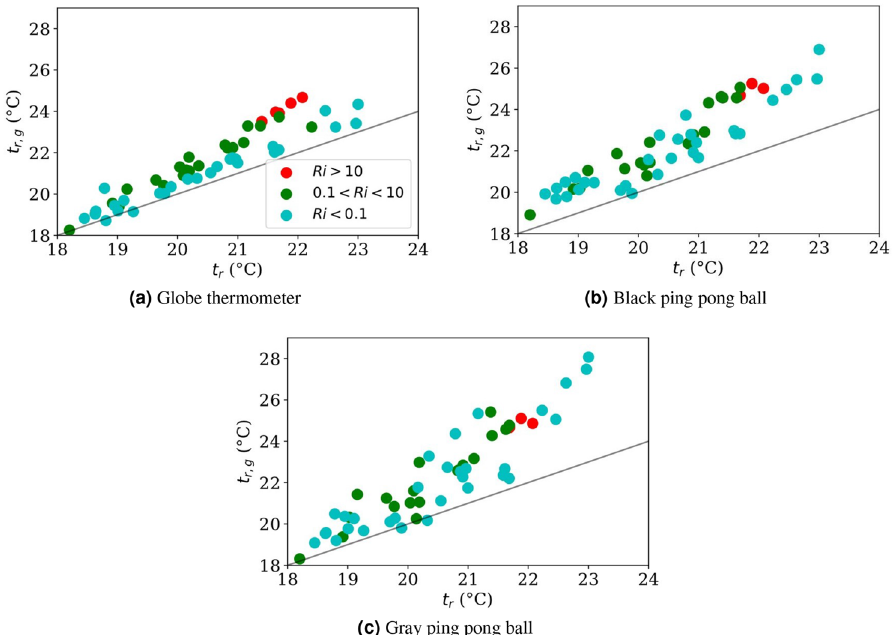
Figure 7. Coloring the datapoints from Fig. 5 based in Ri . Clustering is apparent for the standard globe thermometer, but not either of the ping pong balls. We hypothesize that this indicates ping pong balls are too sensitive to small changes in air speeds to use a physics-based model to back-calculate t r to any reasonable x . degree of precision. The black line is y =